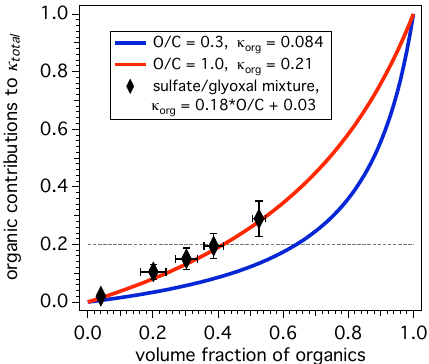
Fig. 8. Calculated contributions by OOA to κ total in mixtures of am- monium sulfate and OOA shown as a function of organics volume fraction. Blue and red lines represent calculated κ -values for mix- tures of ammonium sulfate and OOA with O/C ratios of 0.3 and 1.0, respectively. Black diamond symbols represent measured κ -values for a mixture of ammonium sulfate and glyoxal. Grey dashed line indicates level below which OOA contributions to κ total are consid- ered insignificant ( <